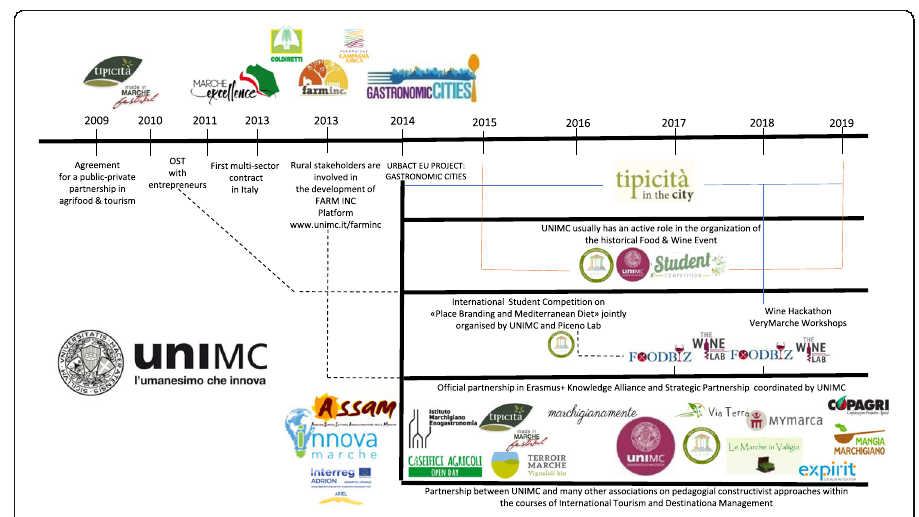
Fig. 1 University of Macerata co-creation pathway (own